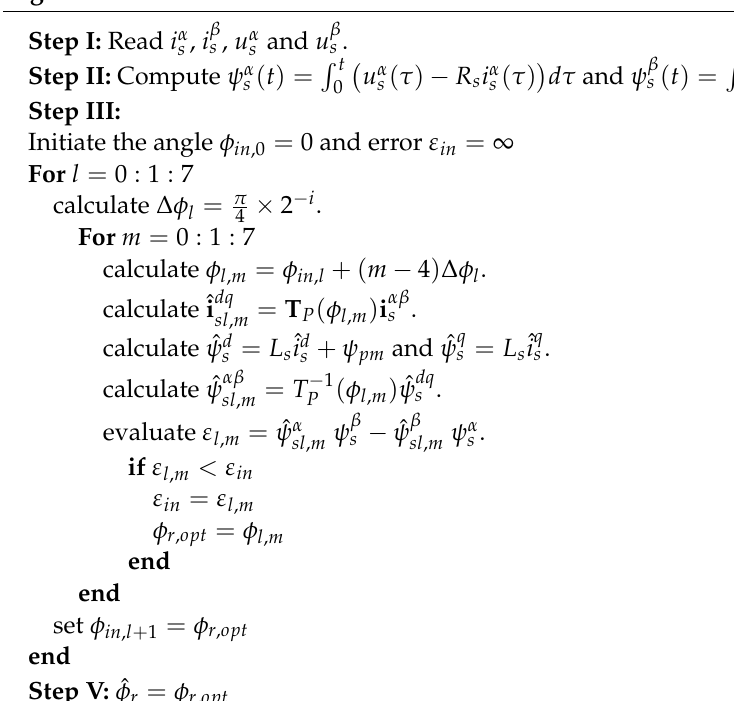
Algorithm 1 MRAS-FS Observer for